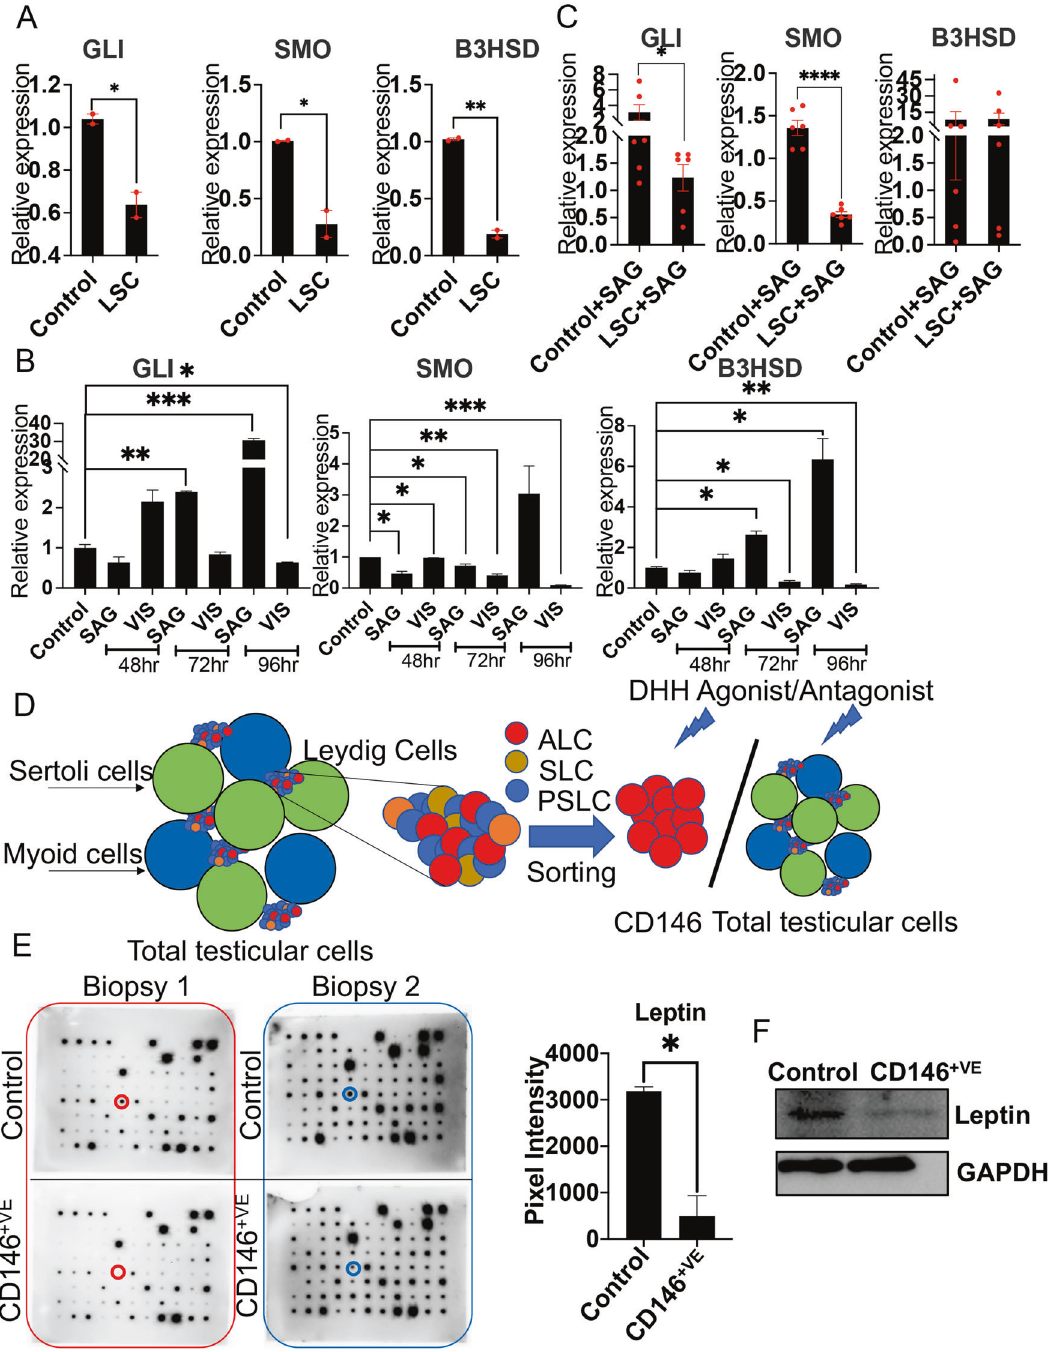
Fig. 2 Role of DHH signaling in differentiation of LSCs. A Comparison of expression of GLI, SMO, and B3HSD in LSCs in the presence (control) or absence (LSC) of the TME (Sertoli and PMCs). B Expression of GLI, SMO, and B3HSD upon DHH agonist and antagonist treatment in LSCs in the presence of the TME in LSCs after 48, 72, and 96 h of treatment. C Schematic representation of steps taken for evaluating paracrine factors released by the TME to support LSC function. Here green circles represent Sertoli cells, blue-PMCs, small red-ALCs, small brown-SLCs, and small blue-PSLCs. Expression of GLI, SMO, and B3HSD upon DHH antagonist treatment in the presence (control) or absence (CD146 + ) of the TME in LSCs. D , E Results of cytokine array and F western blot in the presence (control) or absence (CD146 + ) of TME; leptin expression levels in these cells. Asterisks denote p values (e.g., * p < 0.05, **** p <